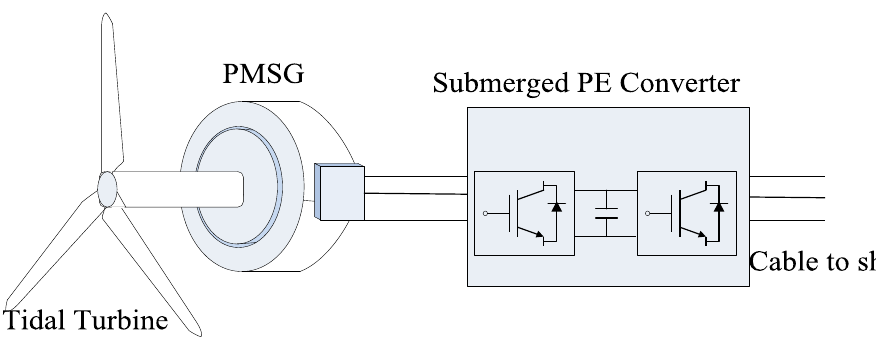
Figure 1. Tidal turbine drive train with a direct-drive permanent magnet synchronous generator (PMSG) and a power electronic (PE) converter.